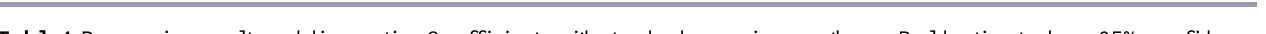
Table 4. Regression results and diagnostics. Coefficients with standard errors in parantheses. Bold estimates have 95% confidence or greater. Max variance inflation factors (VIF) is the largest variance inflation factor for any predictor in the given model. A VIF of 10 or greater is considered an indication of multicolinearity (Fox and Monette 1992). † A random-effects poisson was over-dispersed (dev/df = 2.17; Lindsey 1999), while a negative binomial model without village was not (dev/df = 1.29). Village- level variance were calculated with a mixed effects poisson. ‡ The diversity predictor variable used for workdays was number of castes with 10 or more households. Workdays